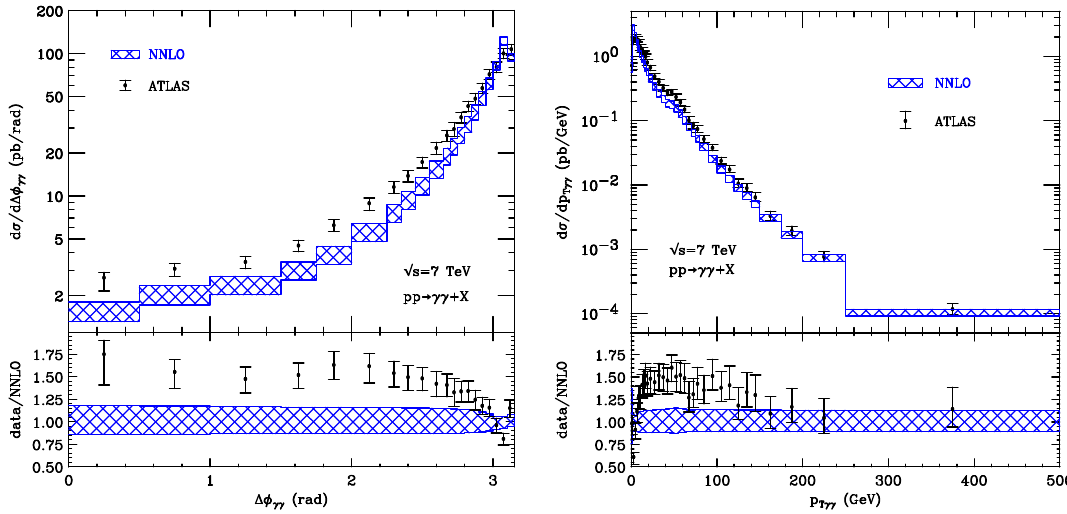
Figure 18 . Comparison between ATLAS data at √ s = 7 TeV [4] and NNLO results (including their scale dependence) for dσ/d ∆Φ γγ (left) and dσ/dp Tγγ (right). The NNLO results are corrected for hadronization and underlying event effects (see